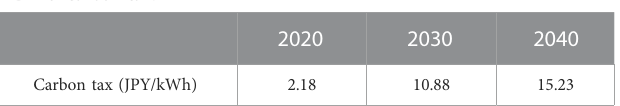
TABLE 9 Carbon tax.